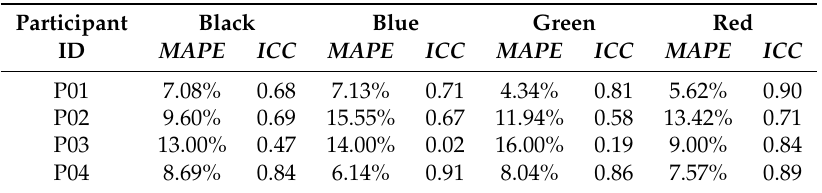
Table 3. Values of Mean Absolute Percentage Error (MAPE) and IntraClass Correlation (ICC) From Treadmill Walking